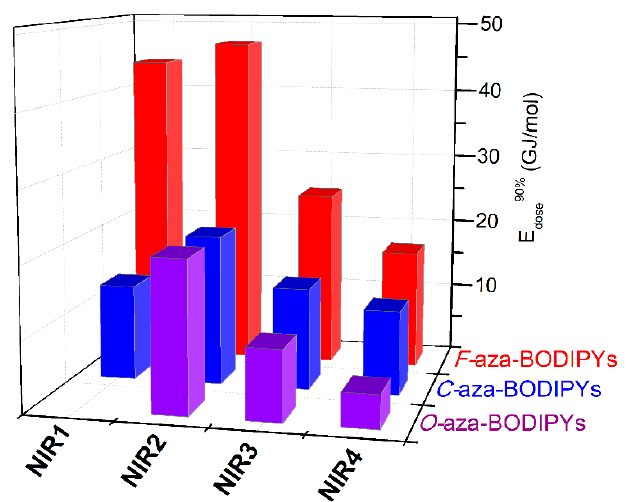
Figure 6. Photostability (energy dose required to decrease 10% of the laser-induced fluorescence E dose90% ) of the F -, C -, and O -aza-BODIPYs in ethyl acetate.